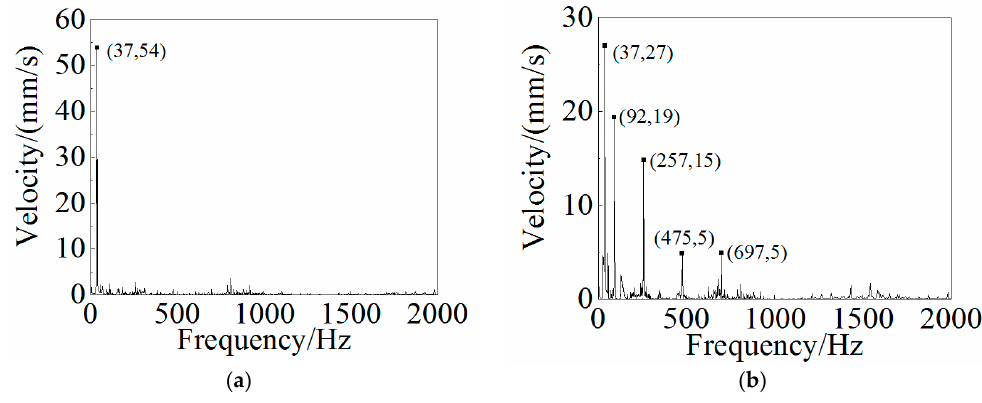
Figure 22. Frequency responses of ( a ) the isotropic and ( b ) the orthotropic oil cooler covers at Point 2 of Figure 20.